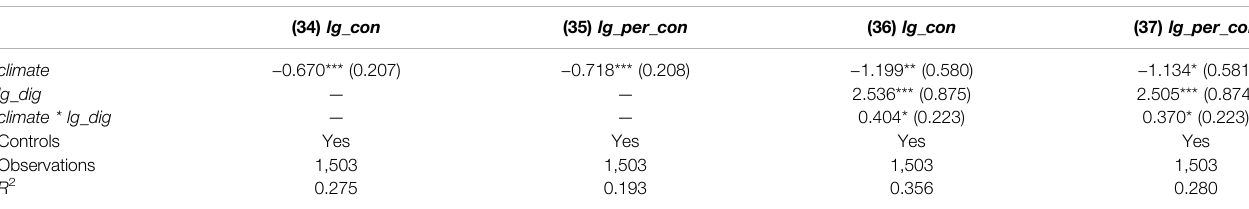
TABLE 8 | Moderating effect of digital fi